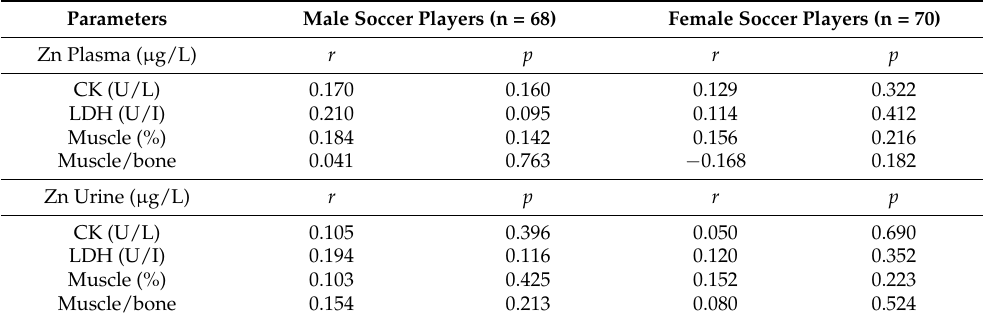
Table 8. Correlations between intracellular and extracellular Zn concentrations with biomarkers of muscle damage and muscle percentage according to